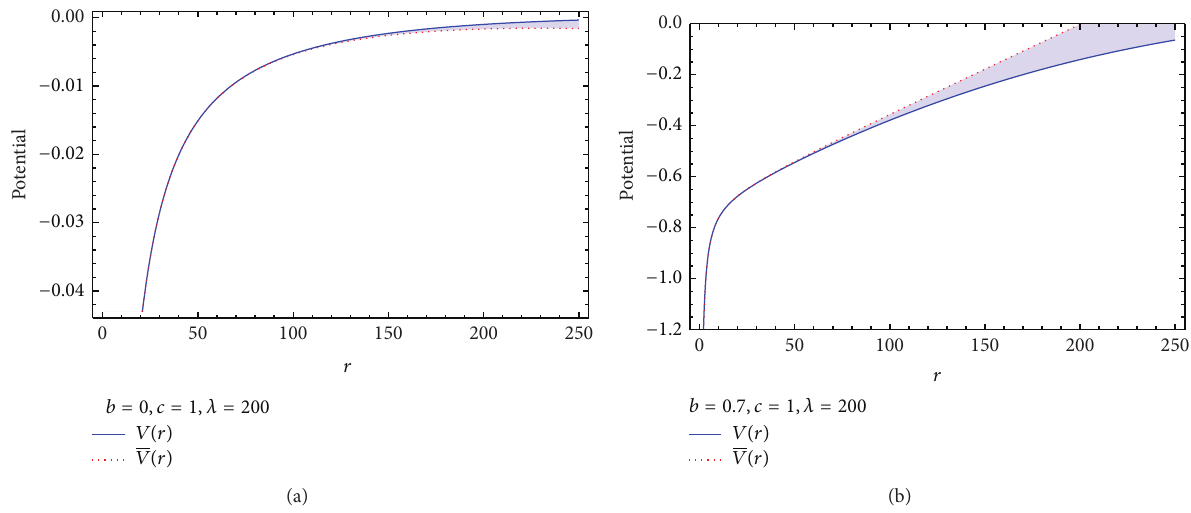
Figure 4: (a) Comparison of 𝑉(𝑟) and 𝑉(𝑟) potentials in case of 𝑏 = 0 , 𝑐 = 1 , and 𝜆 = 200 (in arbitrary units). (b) Comparison of 𝑉(𝑟) and 𝑉(𝑟) potentials in case of 𝑏 = 0.7 , 𝑐 = 1 , and 𝜆 = 200 (in arbitrary units).